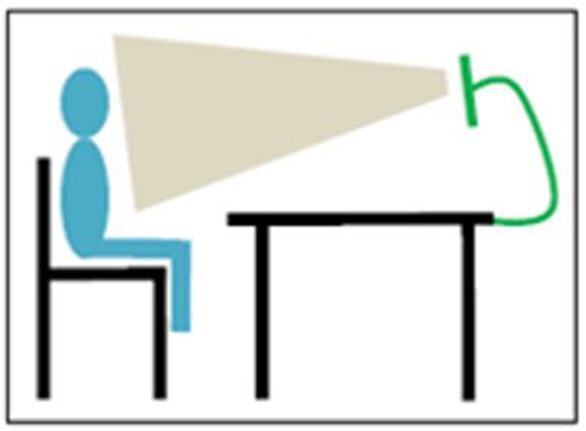
Position of patient and camera while recording.